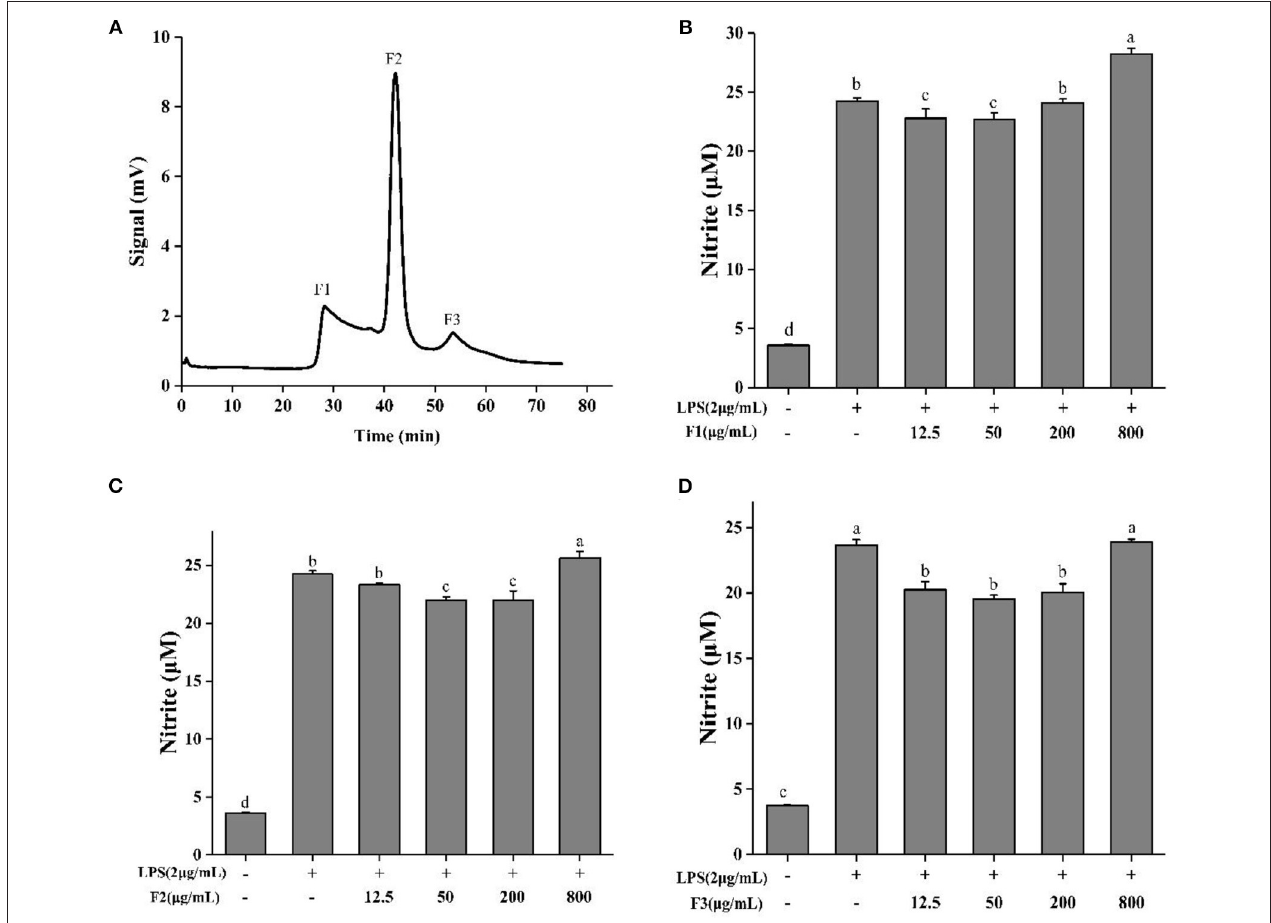
FIGURE 3 | Sephadex G-15 separation (A) of ESCH and NO determination of different components named F1, F2, F3 (B–D) in RAW264.7 macrophage. The results were expressed as means ± SD ( n = 3), where lowercase letters indicate significantly different at p < 0.05.